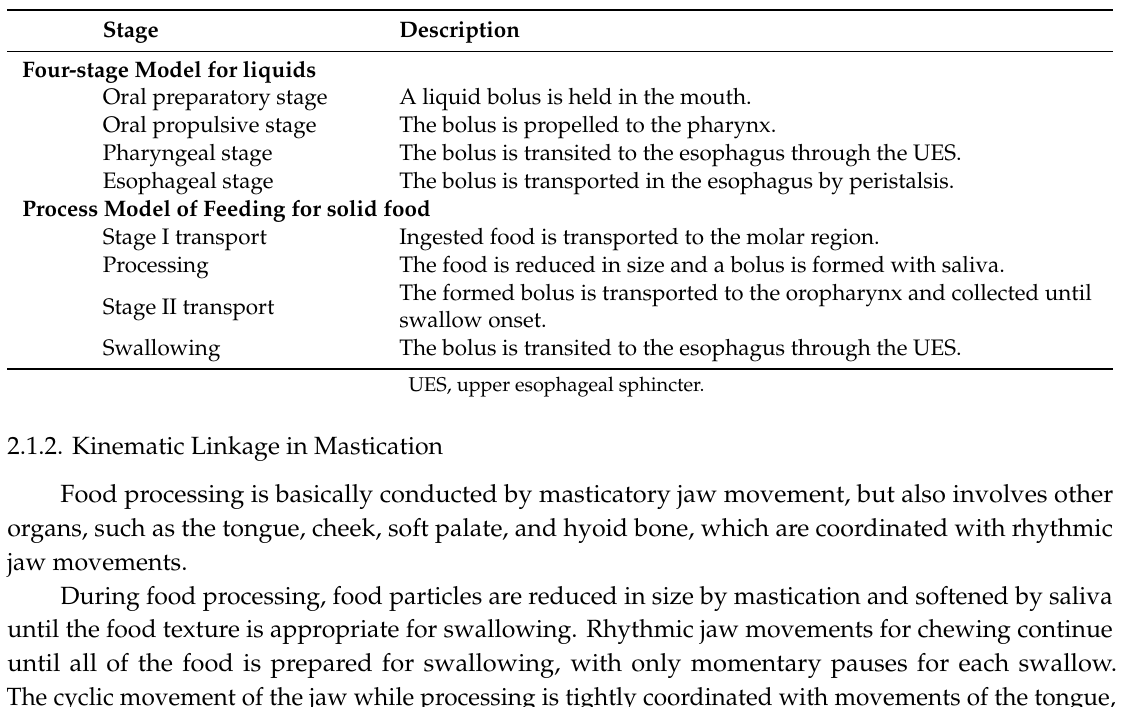
Table 1. Description of stages in the Four-stage Model and Process Model of